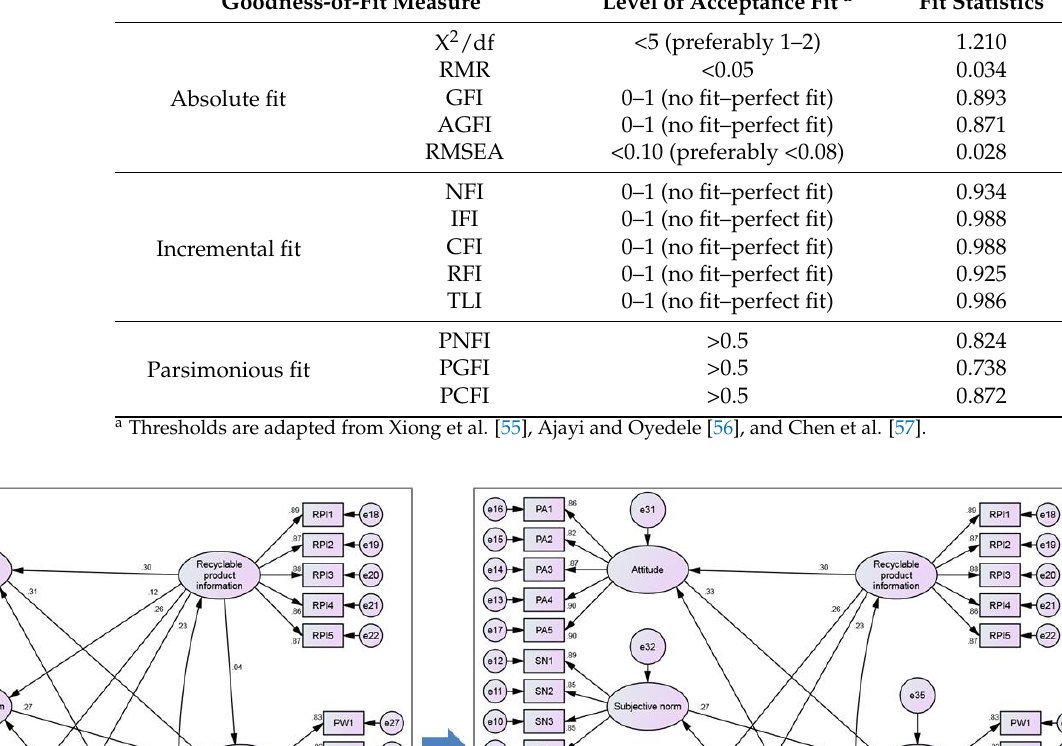
11 of 20 Figure 3. Standardized regression weights of the full measurement model. Table 4. Goodness-of-fit of the initial measurement model.